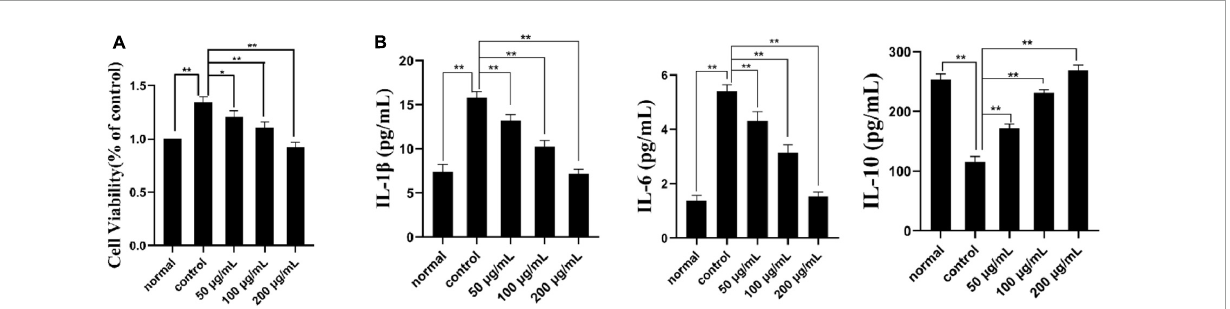
FIGURE6 Cell viability and ELISA assays. (A) The effect of PKP2-1 on the proliferation of MH7A cells; (B) The effect of PKP2-1 on the release of IL-6, IL-10, and IL-1 β from MH7A cells stimulated by TNF- α . * p < 0.05, ** p < 0.01 compared to blank control group.